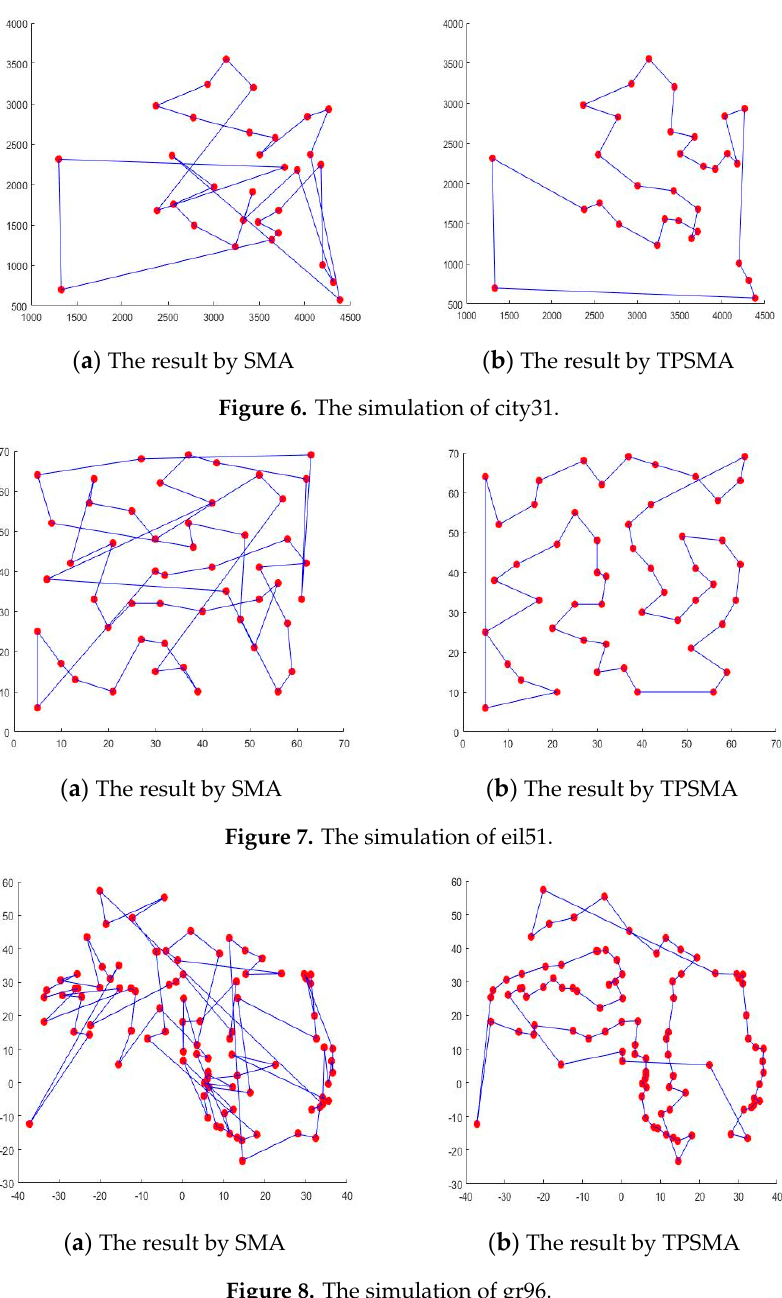
Figure 8. The simulation of gr96.